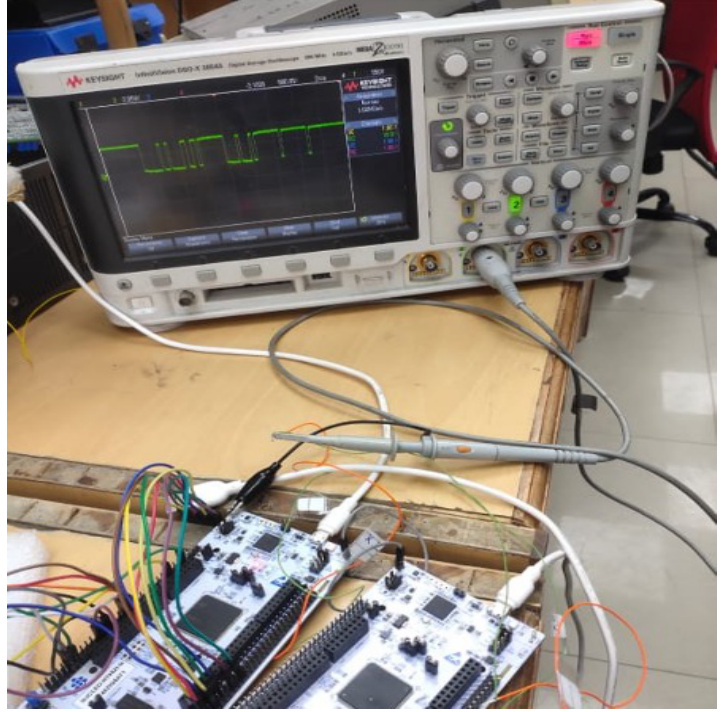
Figure 11. Experimental setup of the proposed pulse generator circuit. The output voltage waveform as obtained from the oscilloscope (DSO) was exported as a .csv for further plotting of the waveform. The output waveform is shown in Figure 12.